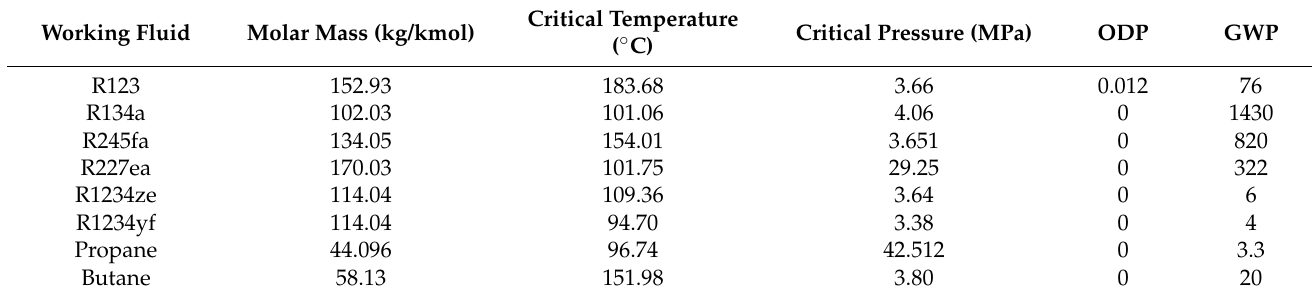
Table 1. Thermophysical properties of the working